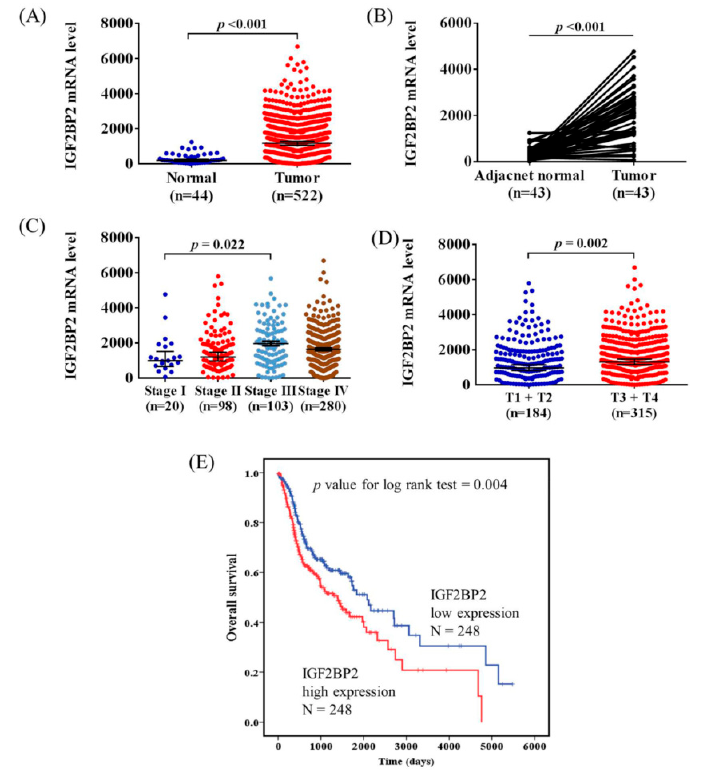
Figure 1. High IGF2BP2 expression was associated with poor survival in patients with head and neck squamous cell carcinoma (HNSCC). ( A ) IGF2BP2 expression in healthy individuals and patients with HNSCC from The Cancer Genome Atlas (TCGA) data portal. ( B ) IGF2BP2 expression in 43 matched tumor tissues and their corresponding noncancerous tissues. ( C ) Comparison of the clinical stage of IGF2BP2 expression. ( D ) Comparison of the tumor T status of IGF2BP2 expression. ( E ) Overall survival analysis of patients with HNSCC with high (red lines) and low (blue lines) IGF2BP2 expression levels. p values were determined using a log-rank test.